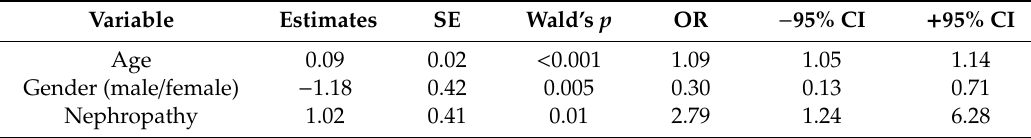
Table 5. Multivariate logistic regression analysis for taking hypnotics by T2DM patients. Variable Estimates SE Wald’s p OR − 95% CI + 95% CI Age 0.09 0.02 < 0.001 1.09 Gender (male / female) − 1.18 0.42